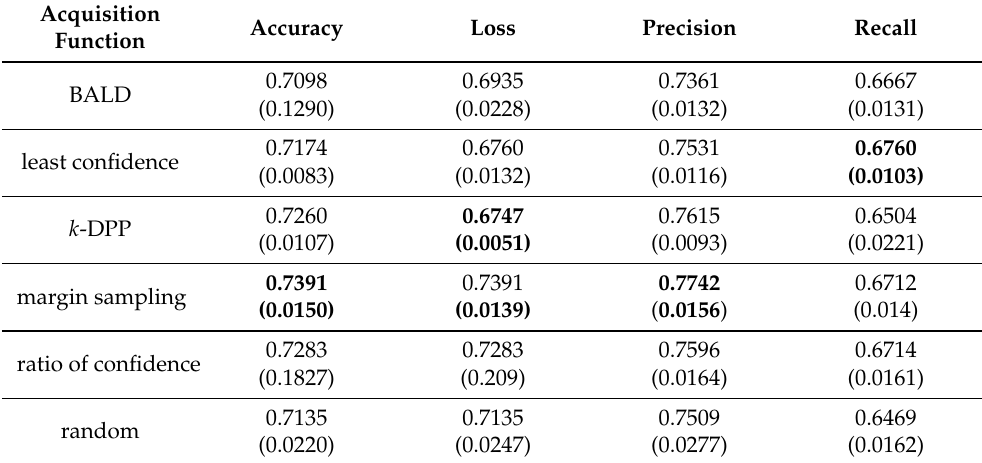
Table 2. Summary of the studied acquisition functions in comparison to the different metrics. Within the table we represent the average and the standard deviation for the results obtained after the last iteration. The best performing acquisition metric is highlighted in by bold